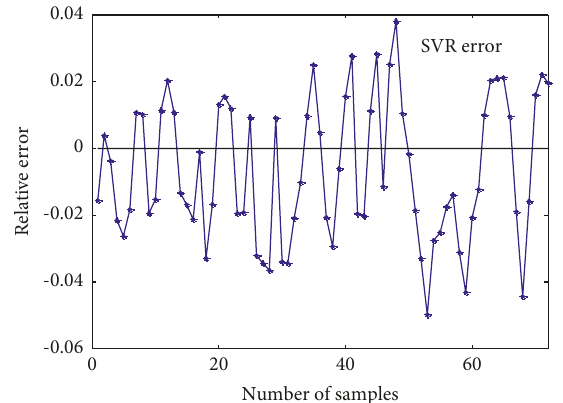
Figure 7: Relative error curve of ethanol concentration based on SVR soft sensing Table 2: Comparison of root mean square error different models. Soft sensing model